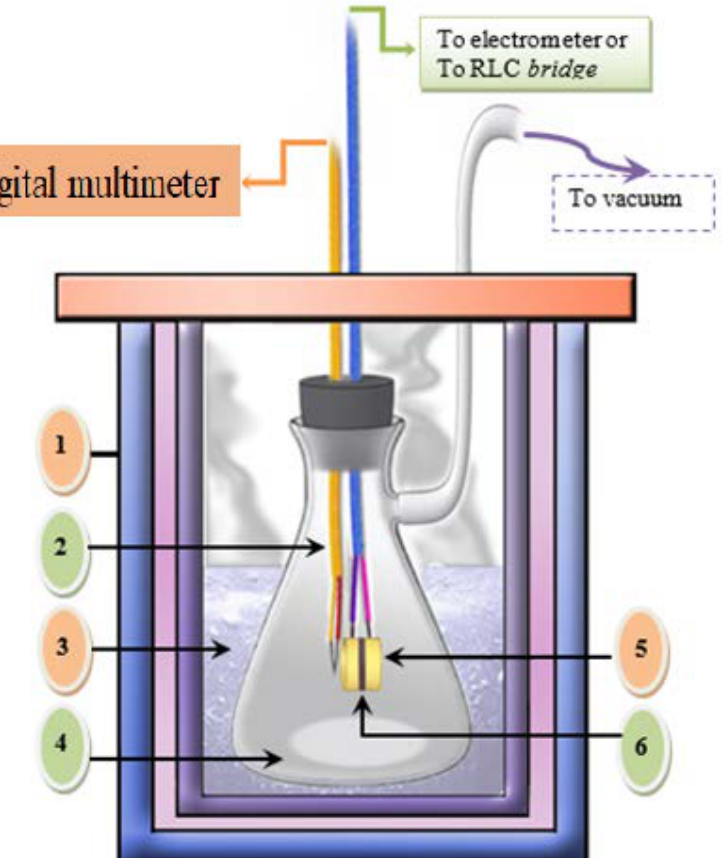
Figure 1. The cell used for measuring DC resistivity and dielectric measurements of the nano-composite samples. 1—insulating jacket. 2—thermocouple. 3—liquid nitrogen. 4—vacuum Büchner flask. 5—two electrodes. 6—the sample.